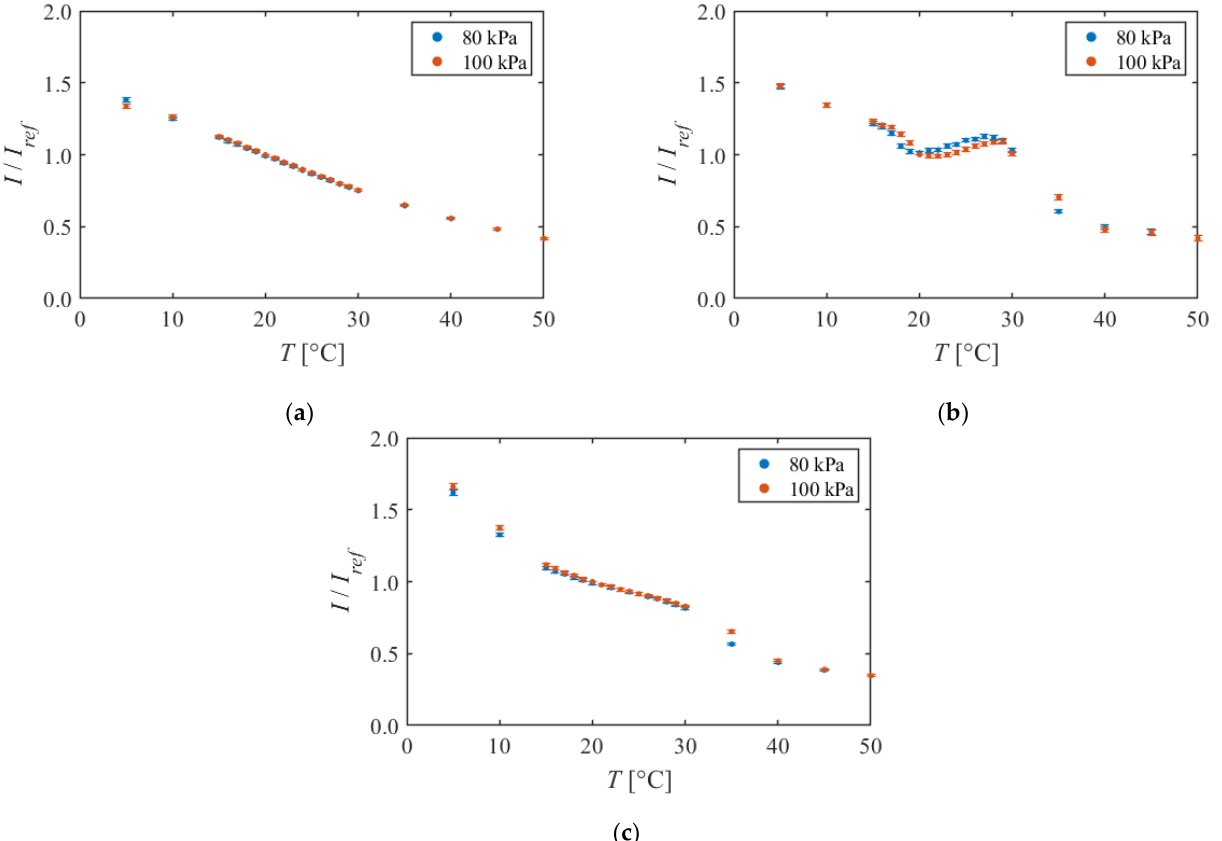
Figure 10. Calibration curves in different pressure conditions. The reference condition is T = 20 °C and P = 100 kPa. ( a ) PAA + EtOH ( C = 100.0 mg/g); ( b ) PMMA + EtOH + Toluene ( C = 102.6 mg/g); ( c ) PMMA + EtOH + DCM ( C = 85.4 mg/g).